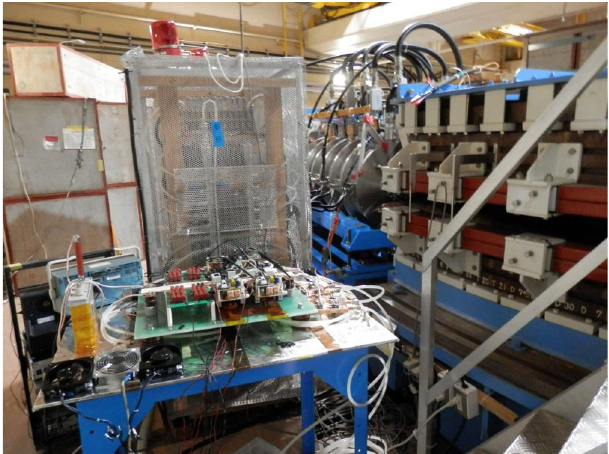
FIG. 7. Test stand to realize the SPS employing the SiC-JFET devices, where the full bridge circuit is mounted on the flat board in the center and the induction cells on the straight section and the bending magnet of the KEK digital accelerator are visible in the right-hand